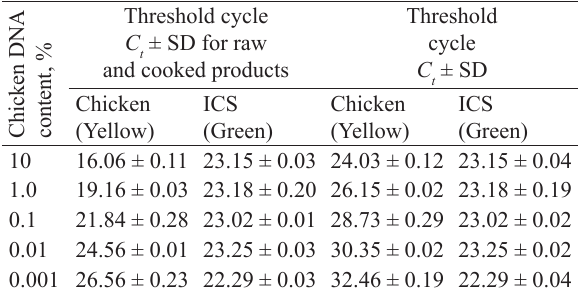
Table 4 PCR results for LOD